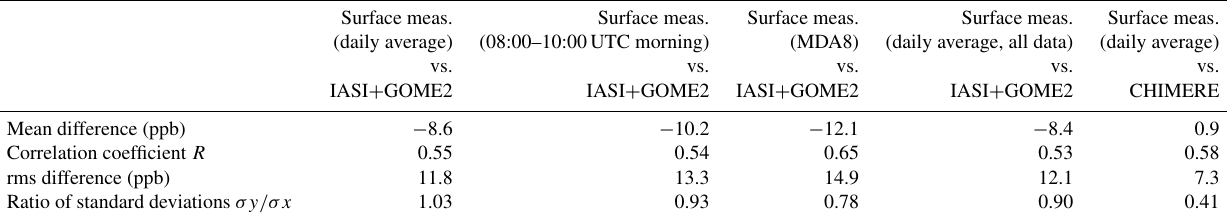
changes in ozone concentrations averaged over 1–15 April 2020 with respect to the same period Figure 2. Scatterplot of (cid:49) O 2020–2019 3 in 2019 (a) at the LMT from the IASI + GOME2 satellite approach and (b) at the surface from the CHIMERE model, with respect to co- localized surface in situ measurement. The colour scale represents the number of occurrences of points within each sector of 2ppb × 2ppb. We consider here only in situ data coincident in time and space with the satellite retrievals. Table 2. Statistics of the comparisons of in situ surface observations with respect to IASI + GOME2 lowermost tropospheric ozone re- trievals and model simulations. All surface in situ measurements and CHIMERE model simulations correspond to data coincident with IASI + GOME2 retrievals on a daily basis, except for the column “Surface meas. (daily average, all data) vs. IASI + GOME2”. Surface meas. Surface meas. Surface meas. Surface